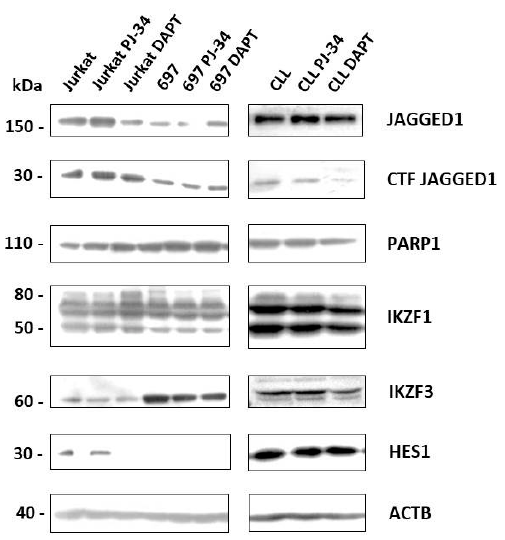
Figure 4. Influence of Notch and PARP pathways’ inhibition on protein expression. T cell line (Jurkat), B chronic lymphocytic cell line (CLL) and B cell precursor leukemia cell line (697) were treated with Notch pathway inhibitor DAPT (20 µM) or PARP inhibitor PJ-34 (10 µM) for nine days, when proteins were isolated and analyzed by Western blot. CTF: C-terminal fragment; ACTB: β -actin.